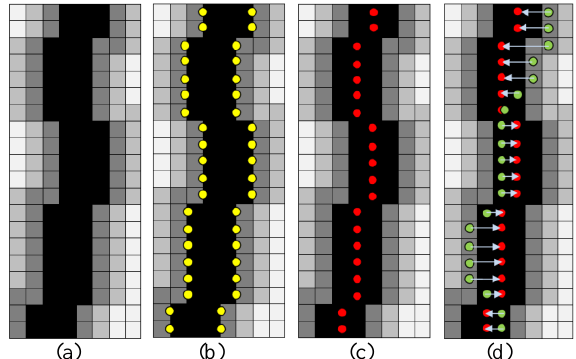
Figure 3. Sketch of the method for the channel edge detection: Tidal channels with low gray values (a) are detected by the minimal and maximal gradients per row (b). The mean of the pixel positions corresponds to the skeleton of the channel (c).